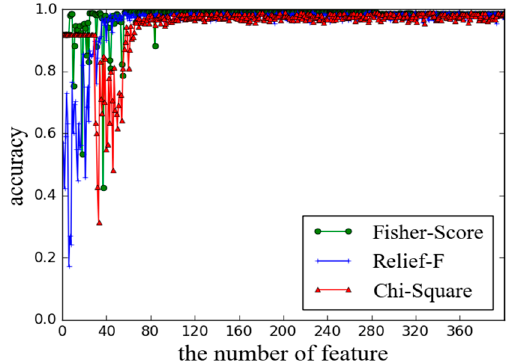
Figure 6. Three feature selection algorithm results in two categories.